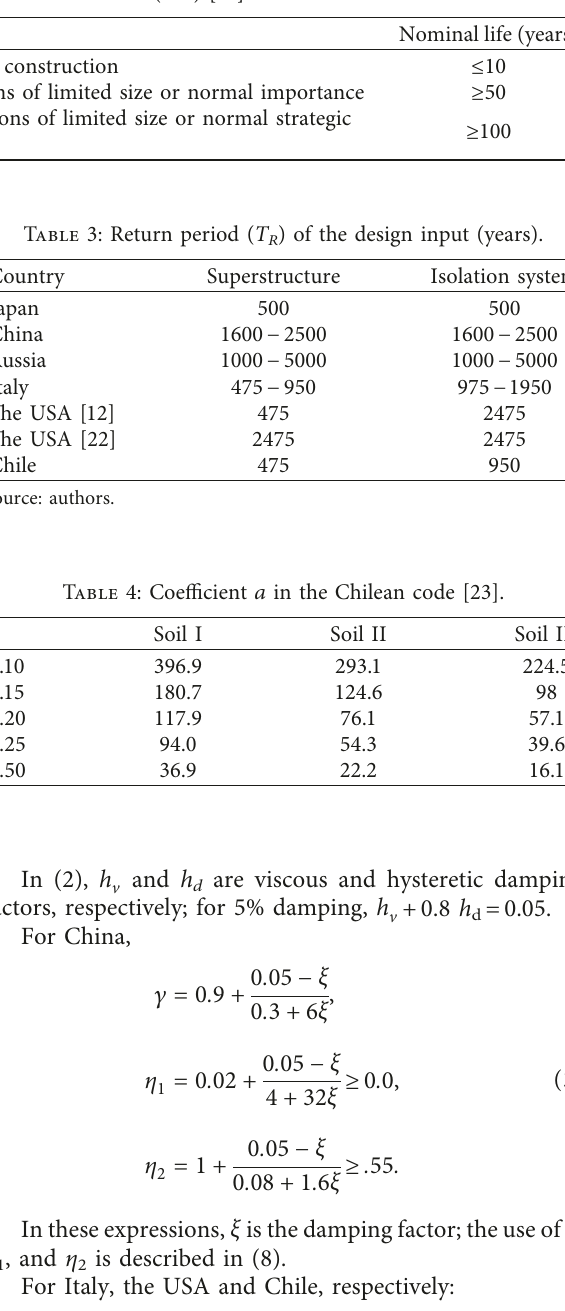
Table 2: Nominal structural life in the Italian code (VN) [17].